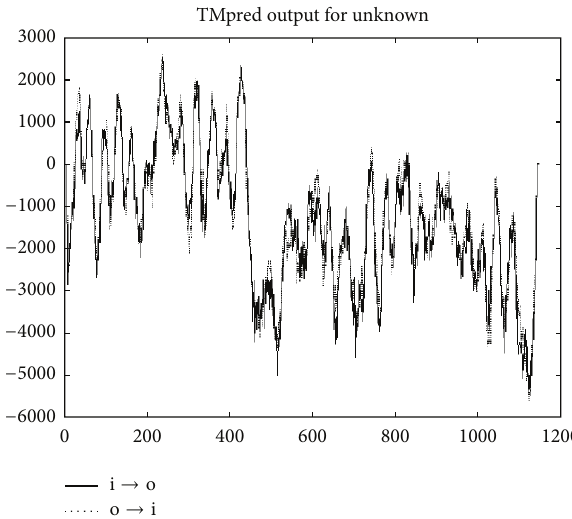
Figure 2: Plot of hydrophobic and hydrophilic areas in